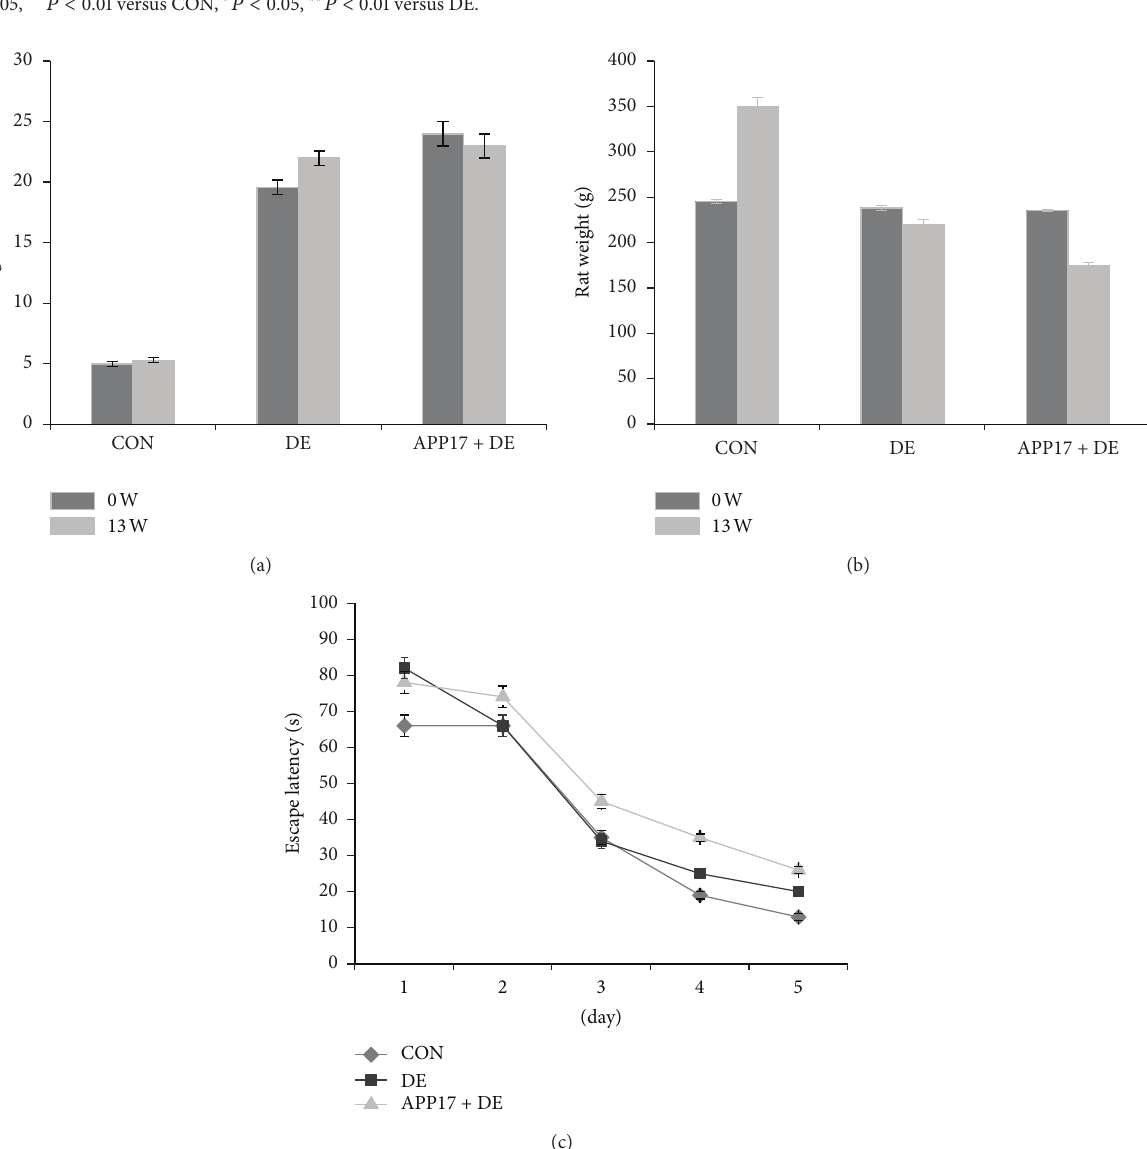
Figure 1: (a) Blood glucose and (b) body weight of mice in 3 groups. (c) The ability analysis of learning and memory of mice in 3 groups.